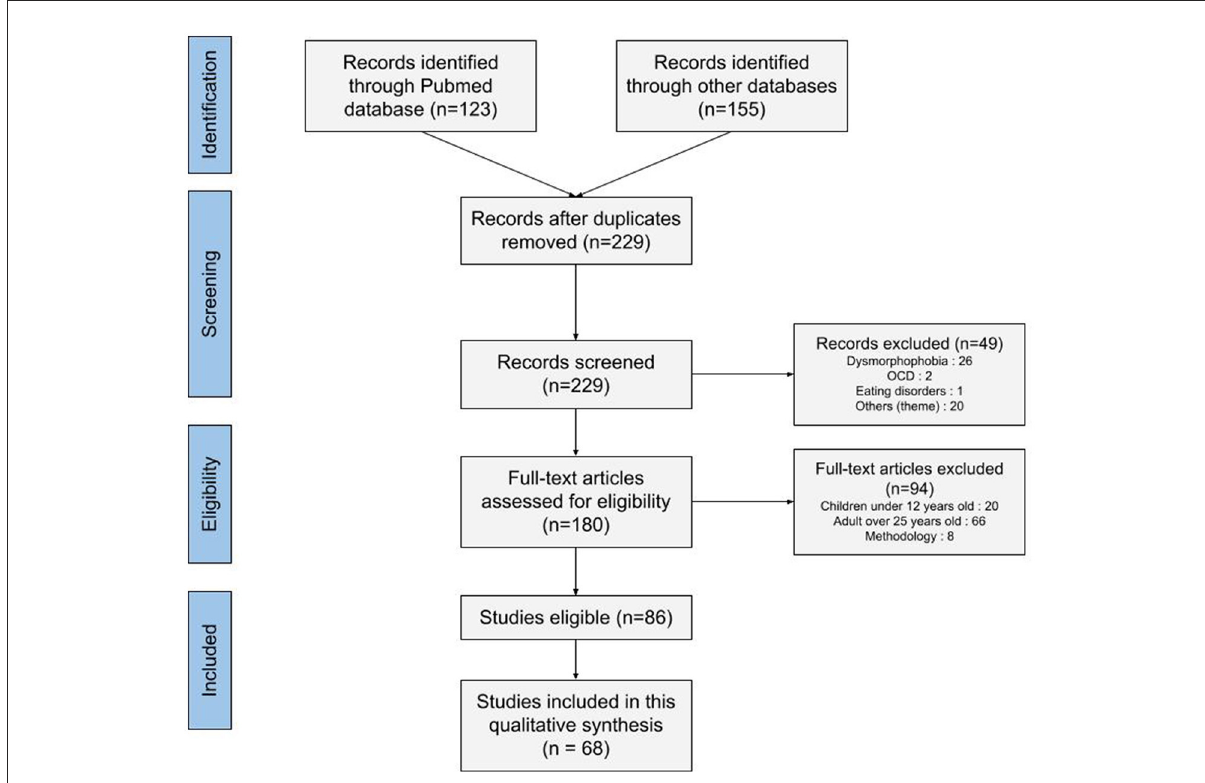
FIGURE1 PRISMA flow diagram for the systematic review.